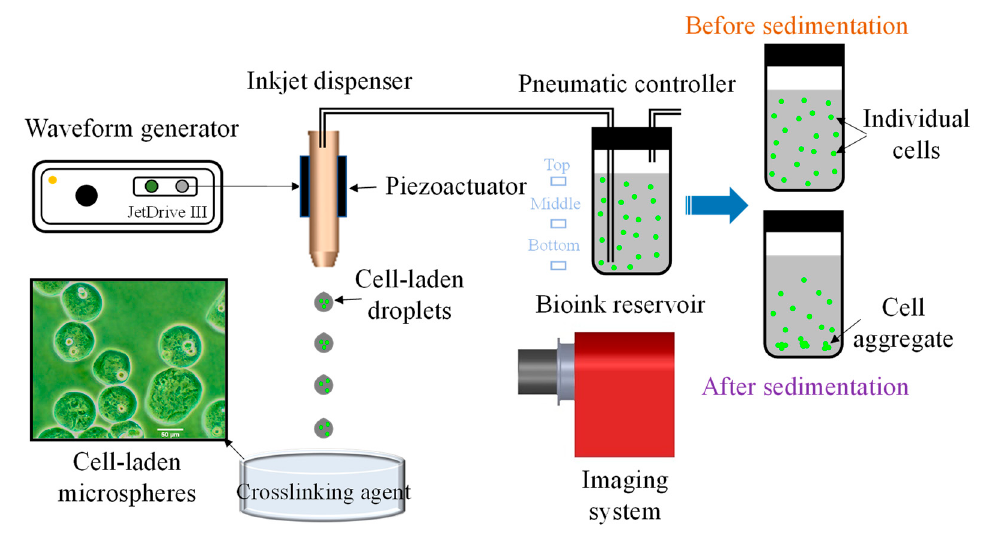
Figure 1. Experimental setup.